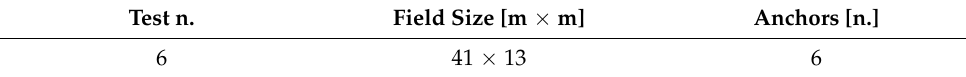
Table 8. Test 6 configuration.